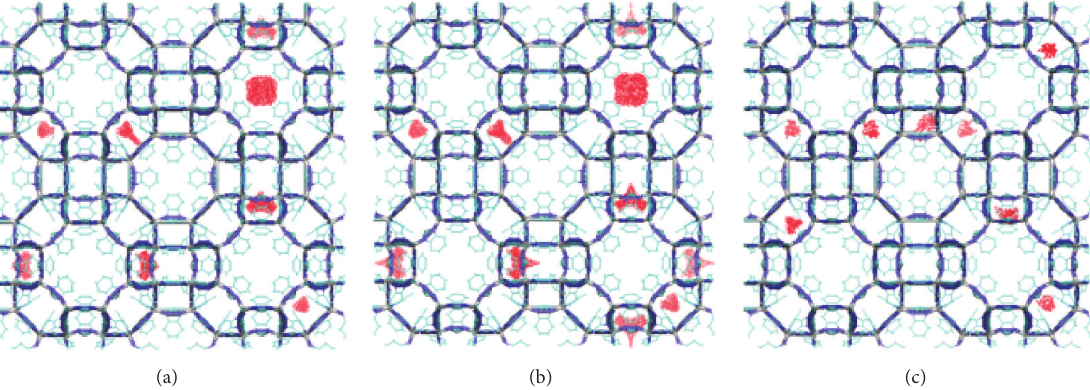
Figure 7: The position distributions of CO 2 molecules in ZIF-11 framework from (a) SIM I, (b) SIM II, and (c) SIM IV simulations, respectively.